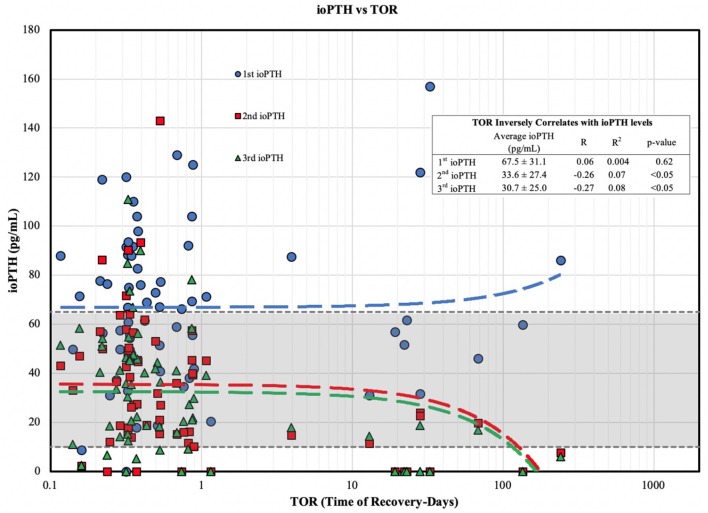
ioPTH vs. TOR for parathyroid gland function. TOR shows an inverse correlation with ioPTH levels divided into risk of post-operative hypoparathyroidism tertiles. The 2nd (red line) and 3rd (green line) ioPTH values are the most predictive for the timing of TOR (in days).